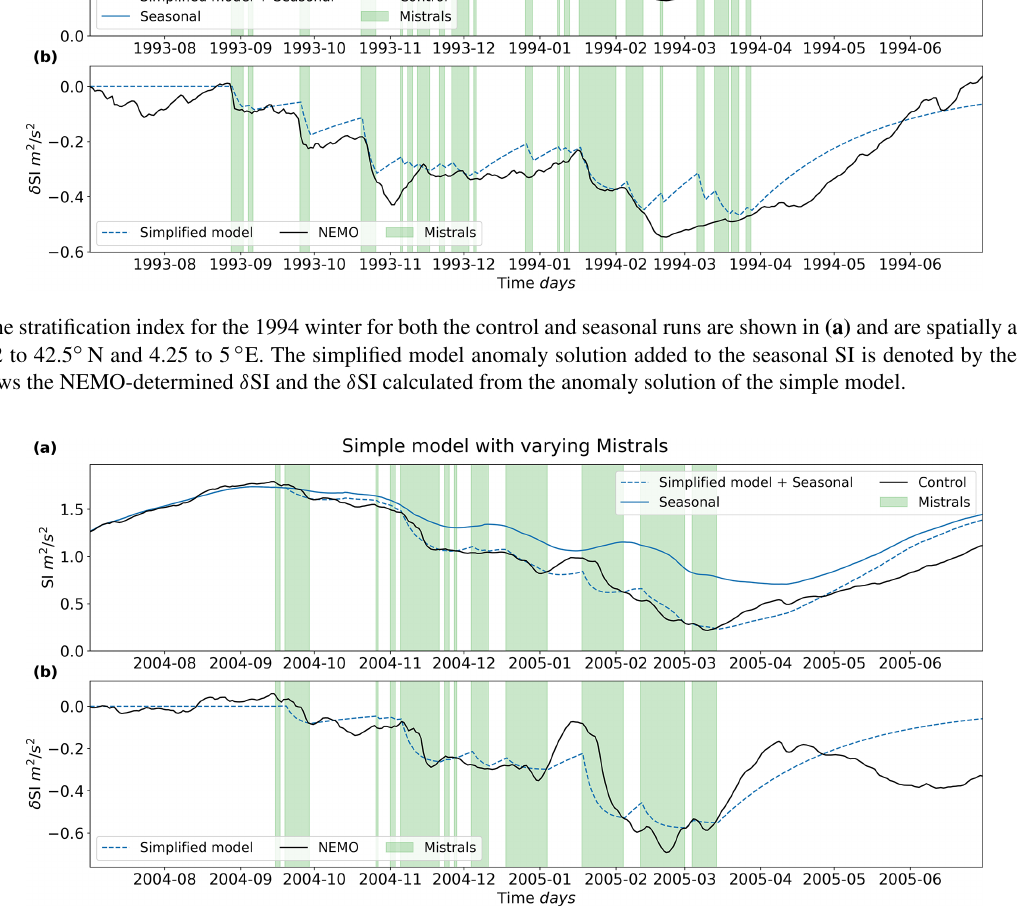
Figure 16. The same as Fig. 15 but for the 2005